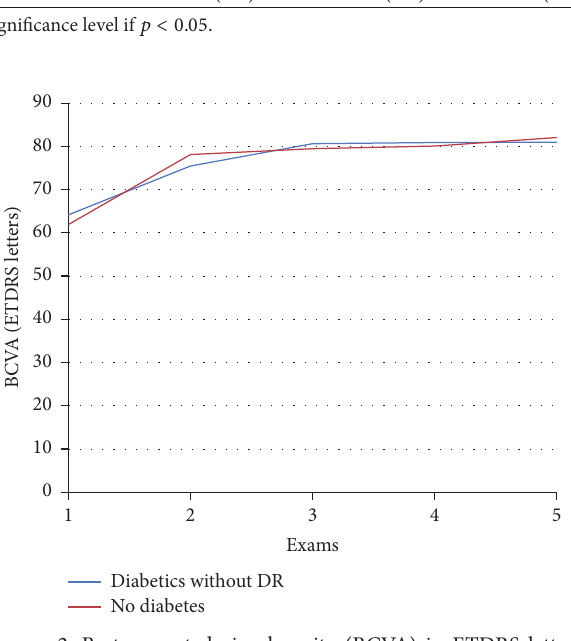
Figure 2: Best corrected visual acuity (BCVA) in ETDRS letters before (exam 1) and after cataract surgery: 1st day (exam 2), 1 month (exam 3), 3 months (exam 4), and 6 months (exam 5).